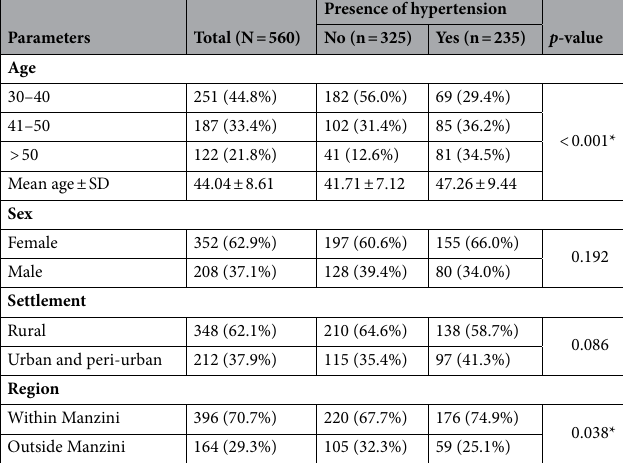
Table 1. Socio-demographic characteristics of study subjects. SD: standard deviation; N: total study population; n: subset of study population; > : greater than; < : less than. *Statistically significant